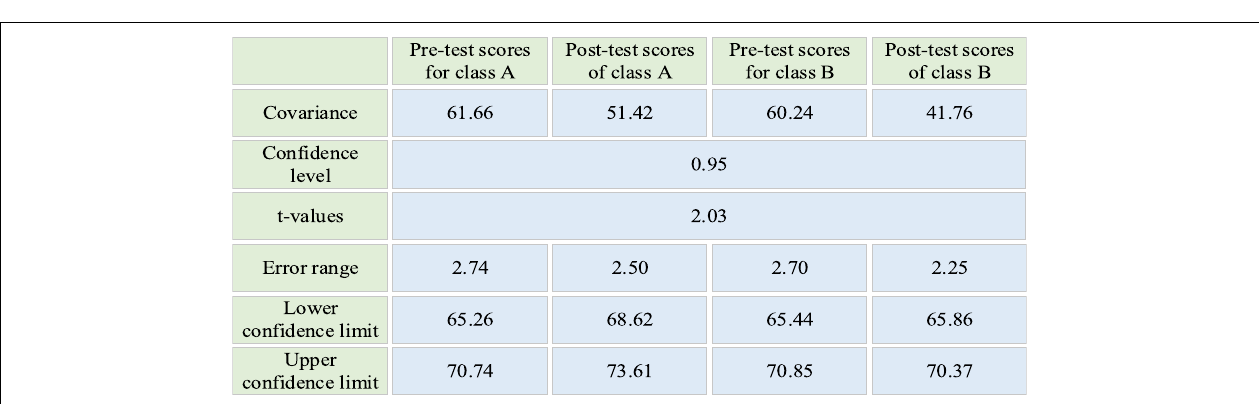
FIGURE 6 | Comparison of pre-and post-test scores of Classes A and